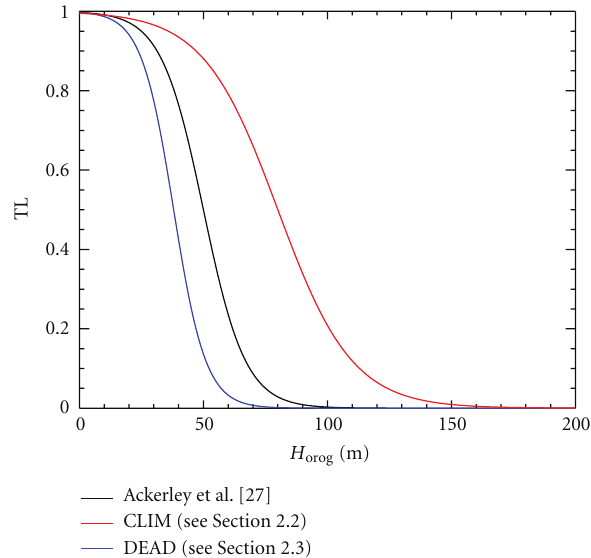
Figure 1: A plot of the topographic “low” source term as given in (3) (red line), (5) (blue line) and the version used in [27] (black